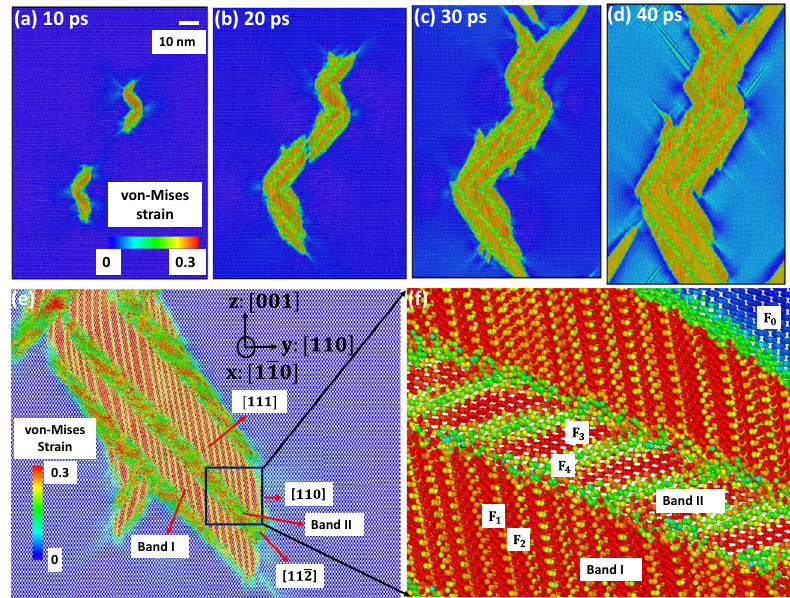
Fig. 3 Snapshot of Si-II microstructure and its rotated and enlarged views. a – d The evolution of the microstructure growing from two dislocation-induced nuclei. e and f The zoomed microstructures composed of the band I, consisting of alternating Si-II variants with deformation gradients F 1 and F 2 (which include elastic strains), separated by ð 110 Þ twinning plane, and interfacial band II, consisting of alternating Si-II variant F 3 and strongly deformed Si-I with deformation gradient F 4 . The interfaces between the two bands and between Si-I and band II are ð 111 Þ planes. Another interface between twinned Si-II and Si-I is ð 110 Þ ; both are not present in the crystallographic theory 1 . Growth occurs by propagation of ð 110 Þ interface along the bands in ½ 11 (cid:2) 2 (cid:3) direction and by nucleation and growth of new twinned Si-II from an interfacial band II, producing next band I and then band II, as observed in the experimental measurement.